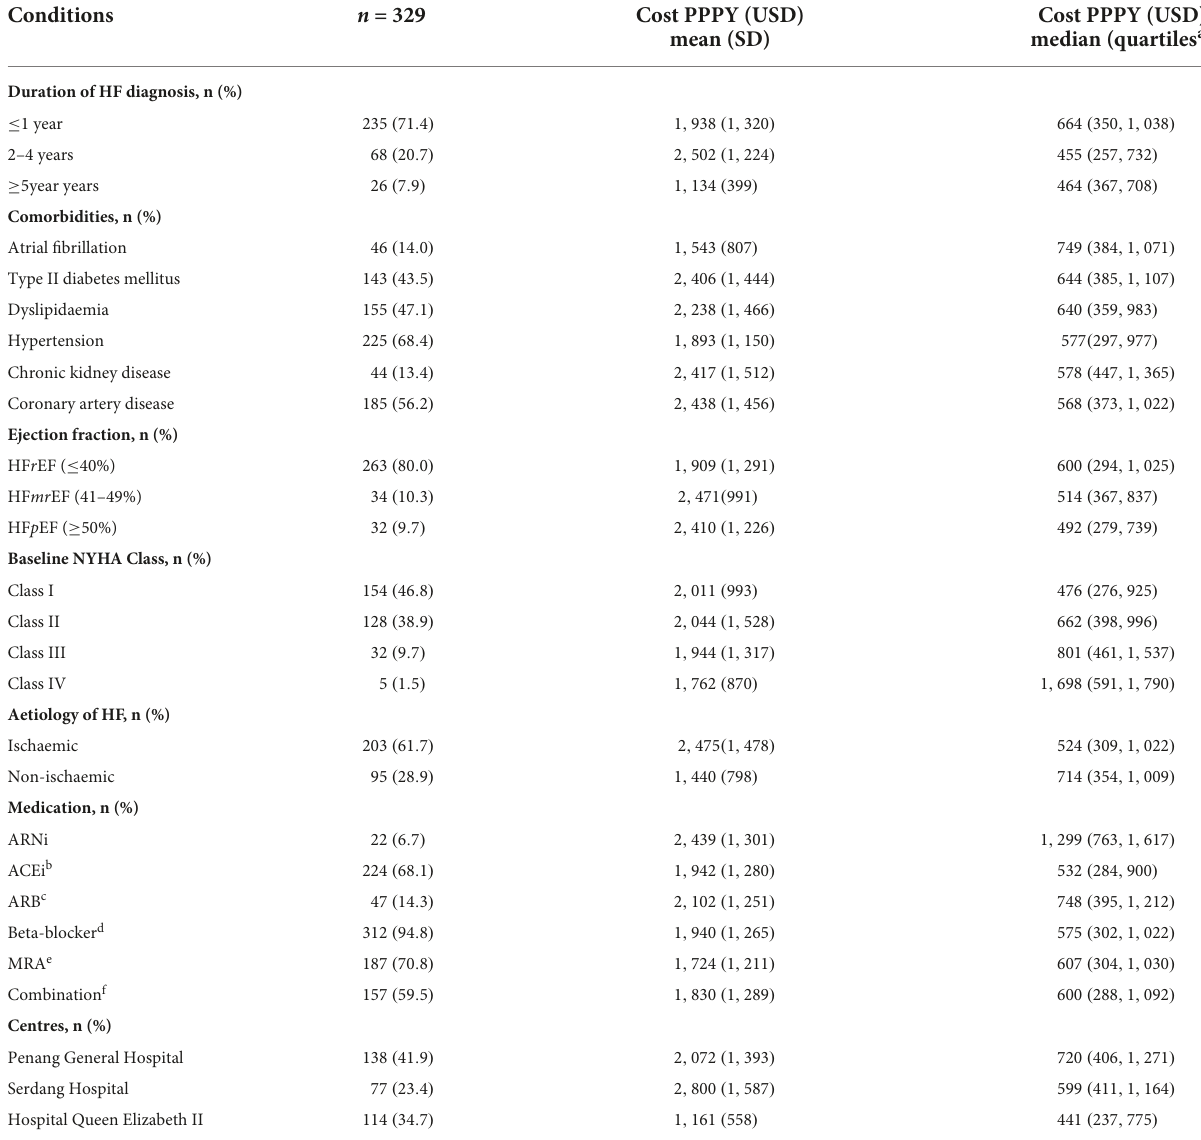
TABLE 4 Annual cost of heart failure patients with different underlying conditions. Conditions n = 329 Cost PPPY (USD)